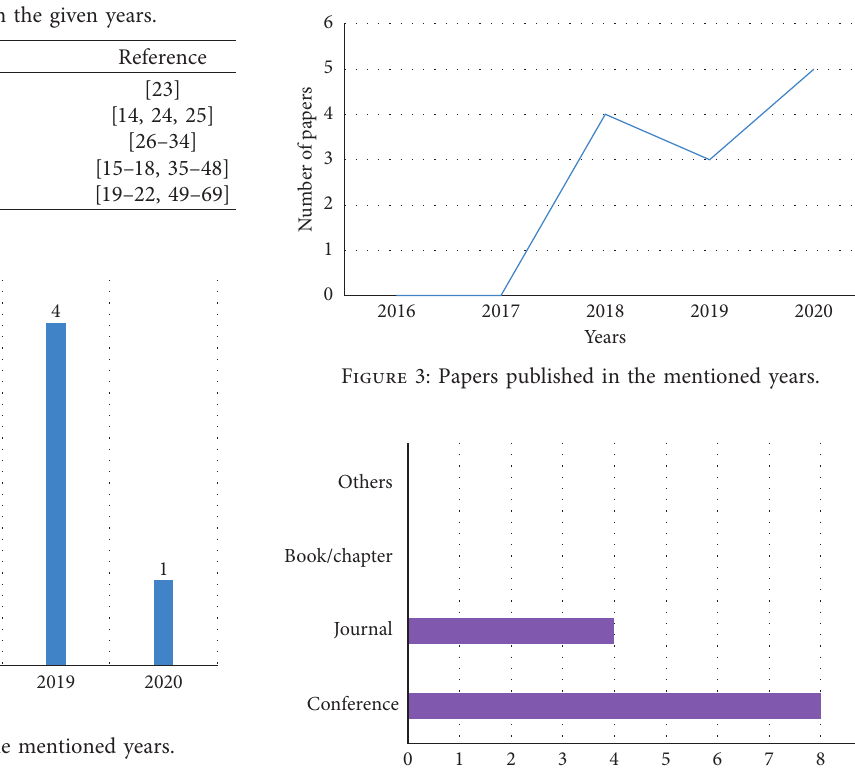
Figure 4: Types of papers along with the number of papers.